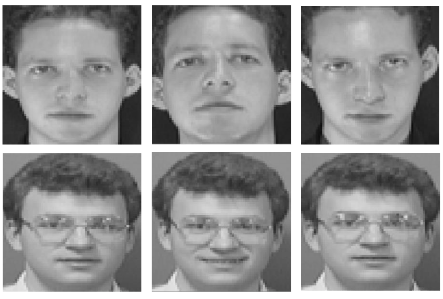
Figure 12. Three sample images for each individuals. In each row, the first and the second are storage patterns, the third is the recognition